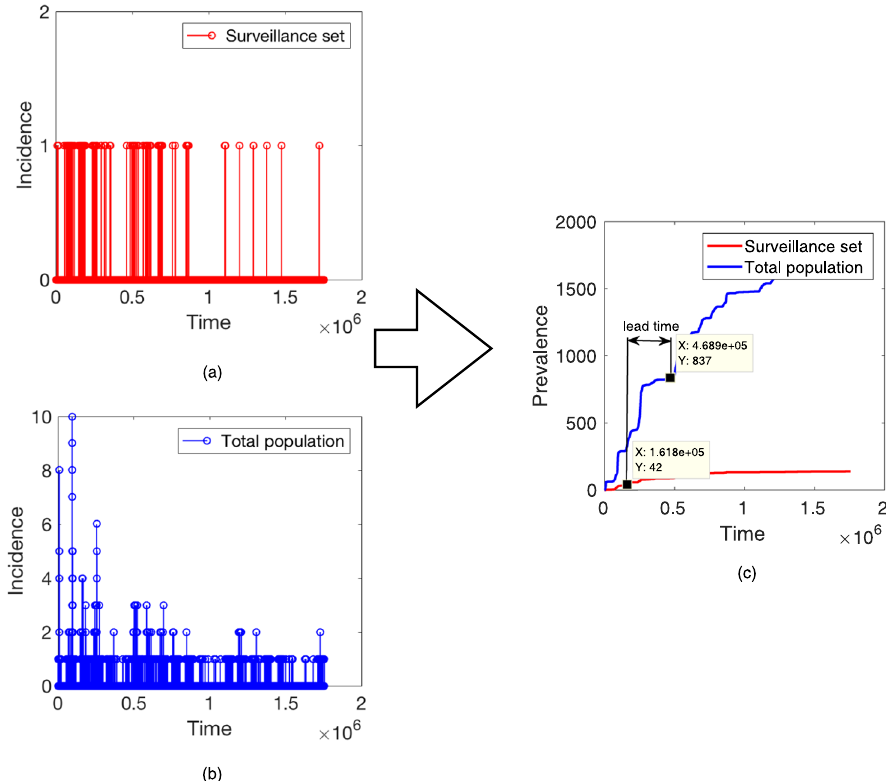
Figure 3. An illustration of an epidemic. In panels (a,b), we see incidence in surveillance set and total population respectively. In panel (c), we calculate the lead time between the surveillance set and total population reaching 1%